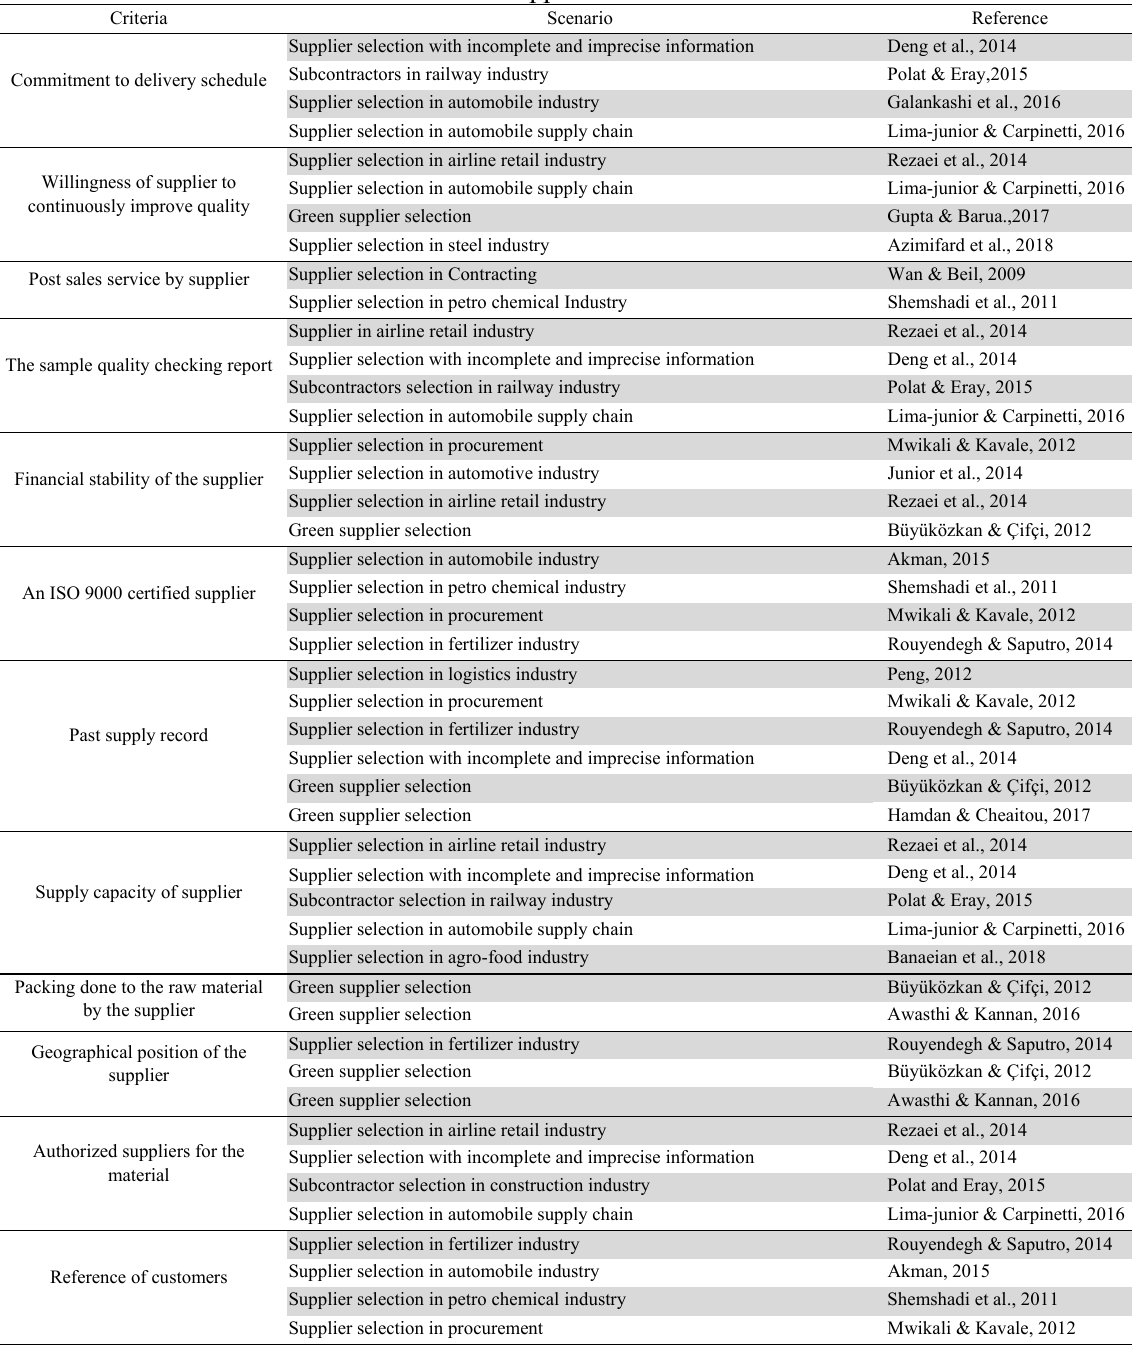
Literature on the scenario of criteria used for supplier